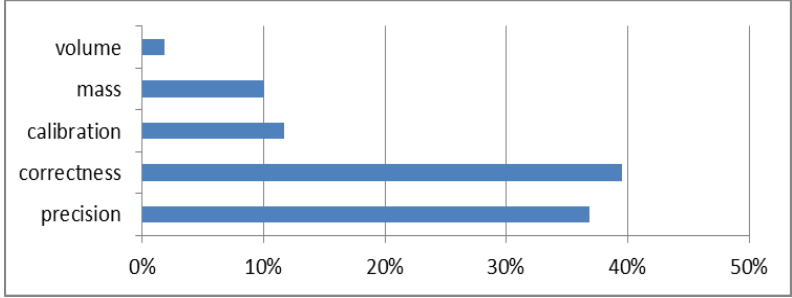
Figure 3. Percentage of components in the uncertainty budget for a silicon content of 10 – 50%.